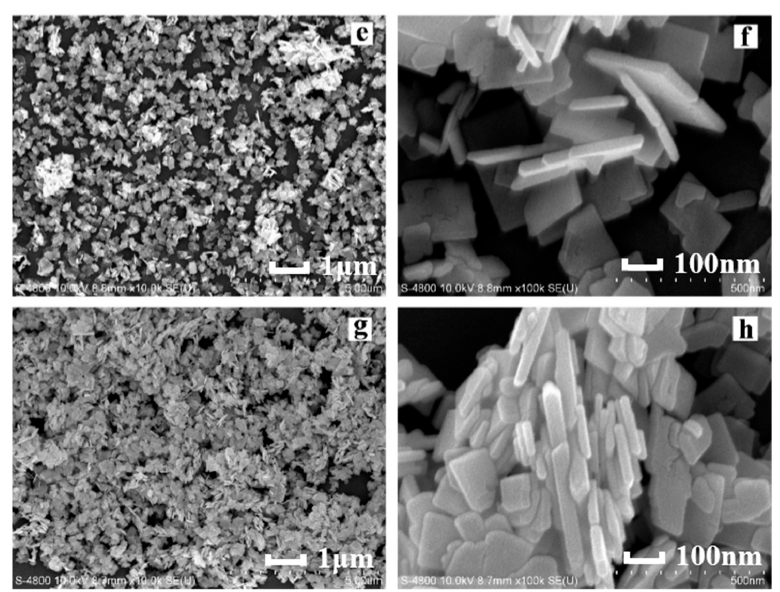
Figure 2. Field-emission scanning electron microscopy (FESEM) images of Bi 2 WO 6 samples prepared using different HNO 3 concentrations: ( a ) ( b ) H0; ( c ) ( d ) H5; ( e ) ( f ) H10; ( g ) ( h ) H15.